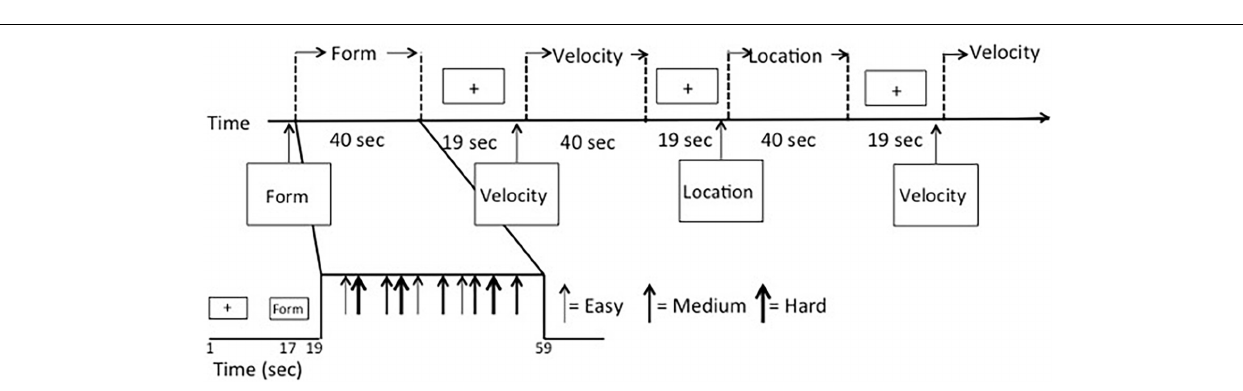
FIGURE 2 | fMRI mixed block/event-related